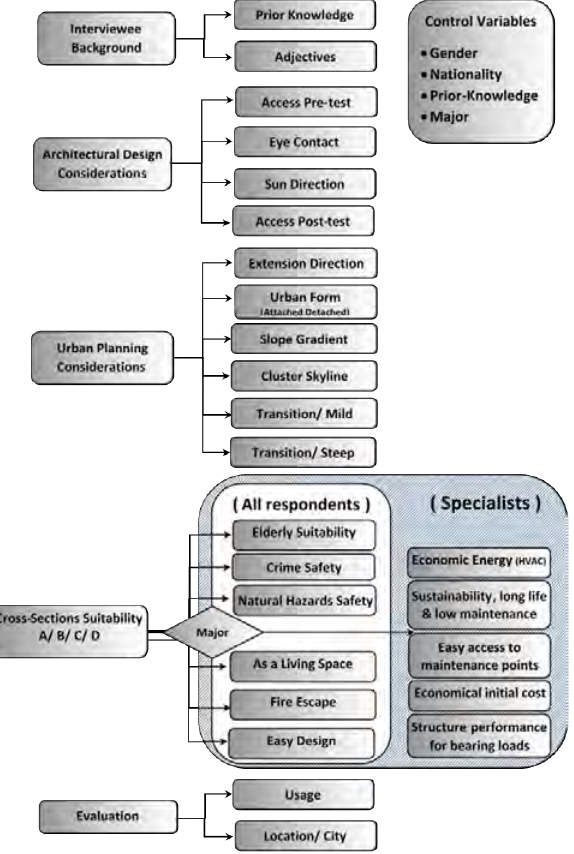
Figure 2. A diagram demonstrating the questionnaire parts and the control